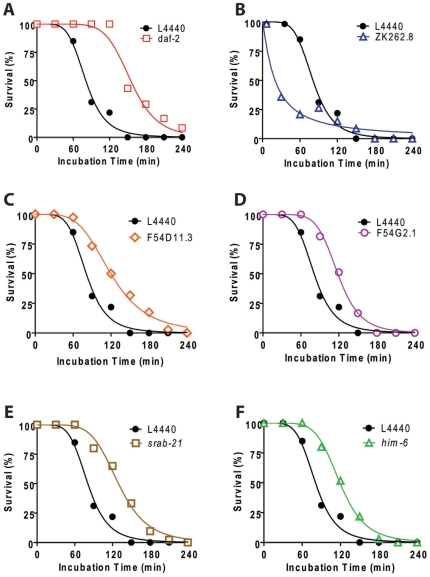
Increased thermotolerance by die gene RNAi knockdown.Survival after recovery from incubations at 37° for various times for worms raised on L4440 empty vector or the denoted RNAi. RNAi's in panel A and C-F produce significantly increased thermotolerance whereas the RNAi in panel B produces significantly decreased thermotolerance – p<0.01, F-test by nonlinear regression and simultaneous curve-fitting. A minimum of 353 animals/curve with at least 18 animals/data point were scored.